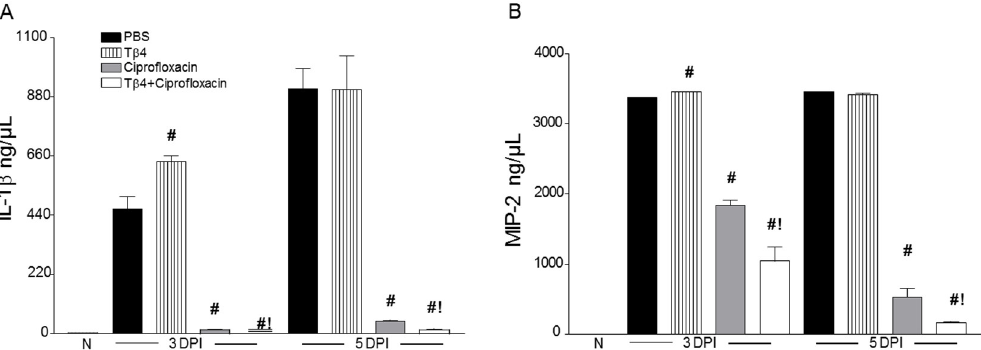
Figure 5. Protein levels of IL-1β ( A ) and MIP-2 ( B ) in corneas of PBS-, Tβ4-, ciprofloxacin-, and Tβ4 + ciprofloxacin-treated B6 mice at 3 and 5 days p.i. and normal, uninfected controls. Results are reported as mean (ng/mL) ± SEM. N = 5 corneas/group/time point. # P < 0.05 versus PBS; ! P < 0.05 versus ciprofloxacin.